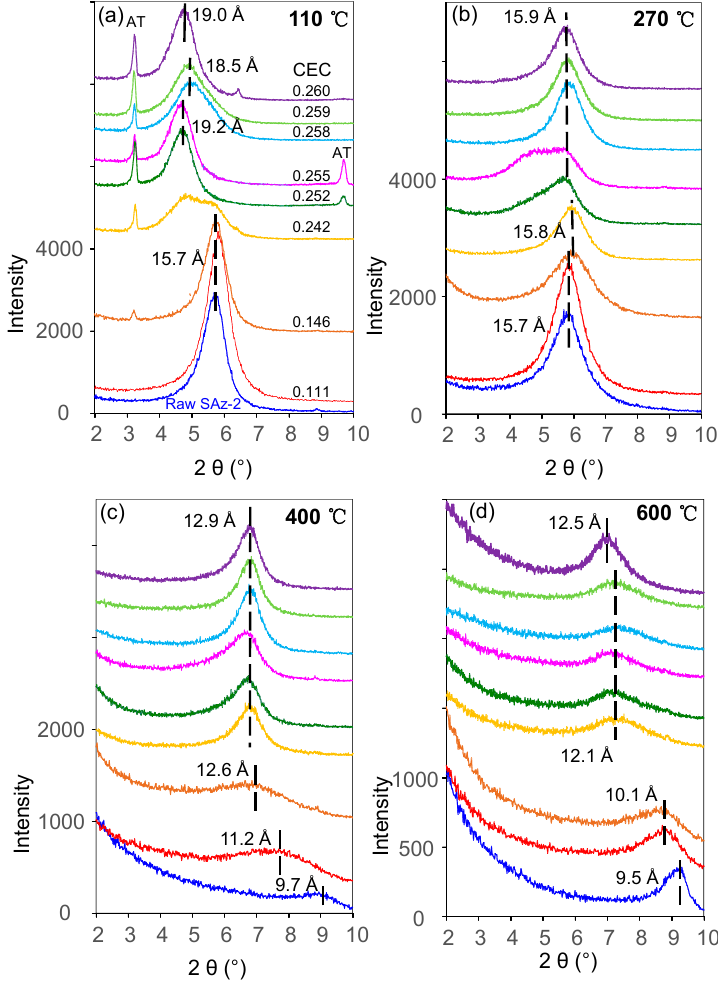
Figure 9. XRD patterns of raw SAz-2 and SAz-2 with different adsorbed amounts of AT without recrystallization from isotherm adsorption for AT under four different heating temperatures: ( a ) 110 °C; ( b ) 270 °C; ( c ) 400 °C; ( d ) 600 °C.